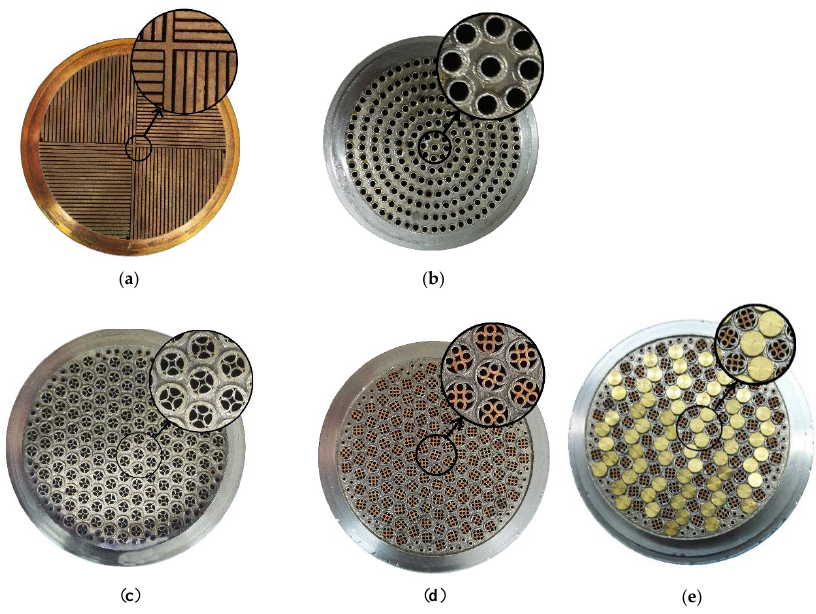
Figure 3. Photographs of ( a ) WCHX 1; ( b ) WCHX 2; ( c ) WCHX 3; ( d ) WCHX 4; and ( e ) WCHX 7. WCHXs 5 and 6 had the same gas channels as WCHX 4. Table 2. Parameters of the WHCXs.